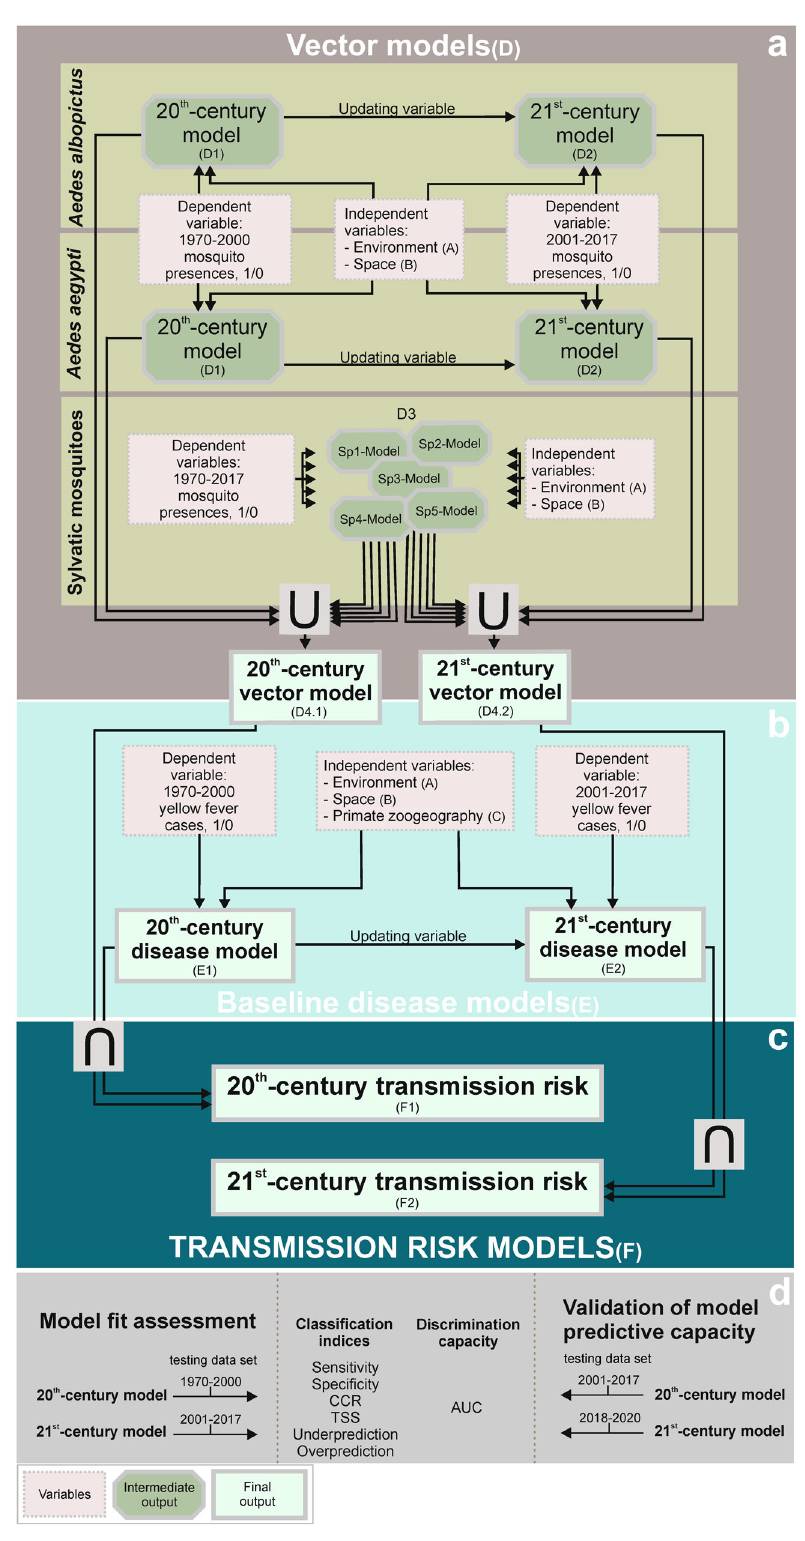
Fig. 1 Methodological steps of the approach used for yellow fever transmission risk modelling. a Vector models result from combining, through the fuzzy union ( ∪ ), favourable areas for the presence of urban ( Ae. aegypti and Ae. albopictus ) and sylvatic vectors. b Baseline disease models describe the areas favourable to the occurrence of yellow fever cases. c Transmission risk models quantify the level of yellow fever transmission risk, according to the fuzzy inteserccion ( ∩ ) between vector and baseline disease models. d Model fi t assessment and validation of model predictive capacity. Methodological details are given in Supplementary Methods, which includes very detailed methodological explanations for all elements with a code in parentheses: A, B, C, D1, D2, D3, D4.1, D4.2, E, E.1, E.2, F, F.1, F.2.